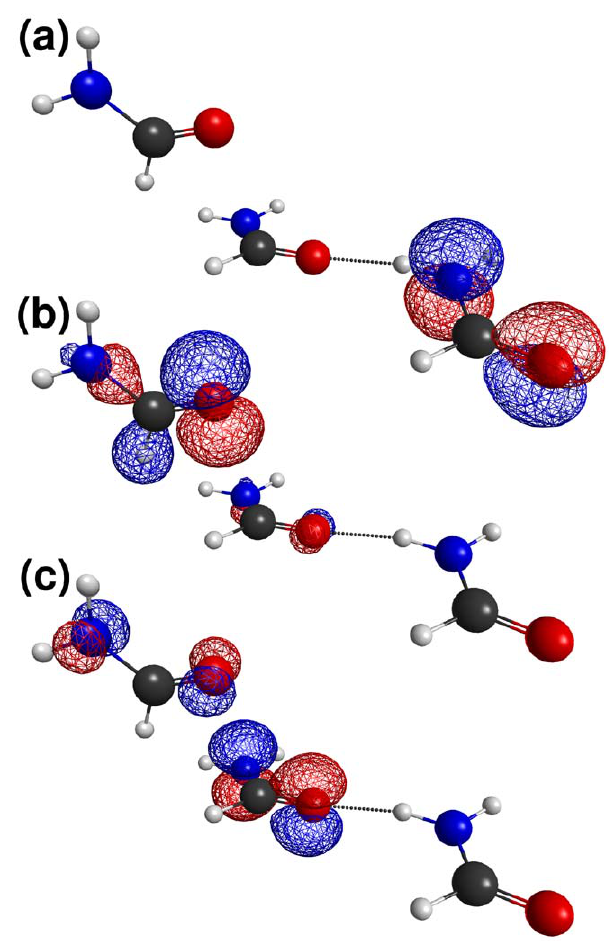
Figure 4. Formamide Trimer Model. Molecular orbitals of ( A ) the hydrogen bond donor, ( B ) the putative n p { p (cid:1) donor and ( C ) the putative n p { p (cid:1) acceptor, in the trimeric complex used in quantum chemical calculations.